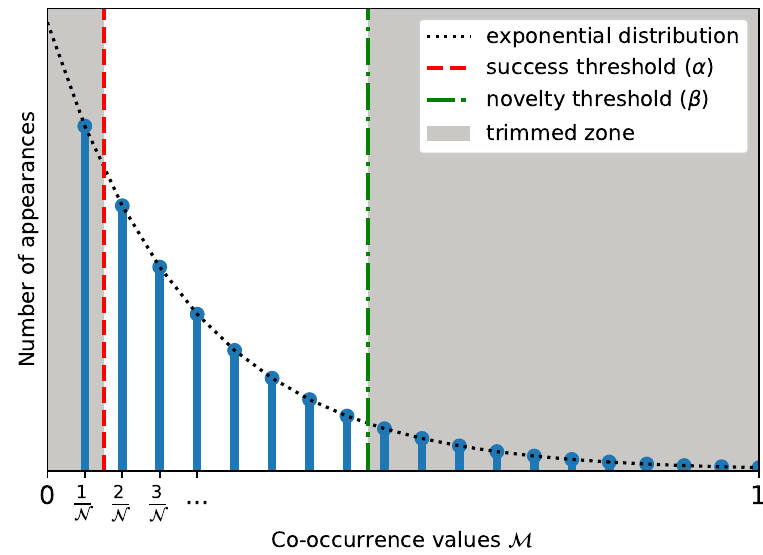
Figure 1. Distribution of terms co-occurrence values M ( i , j ) in a corpus of size N